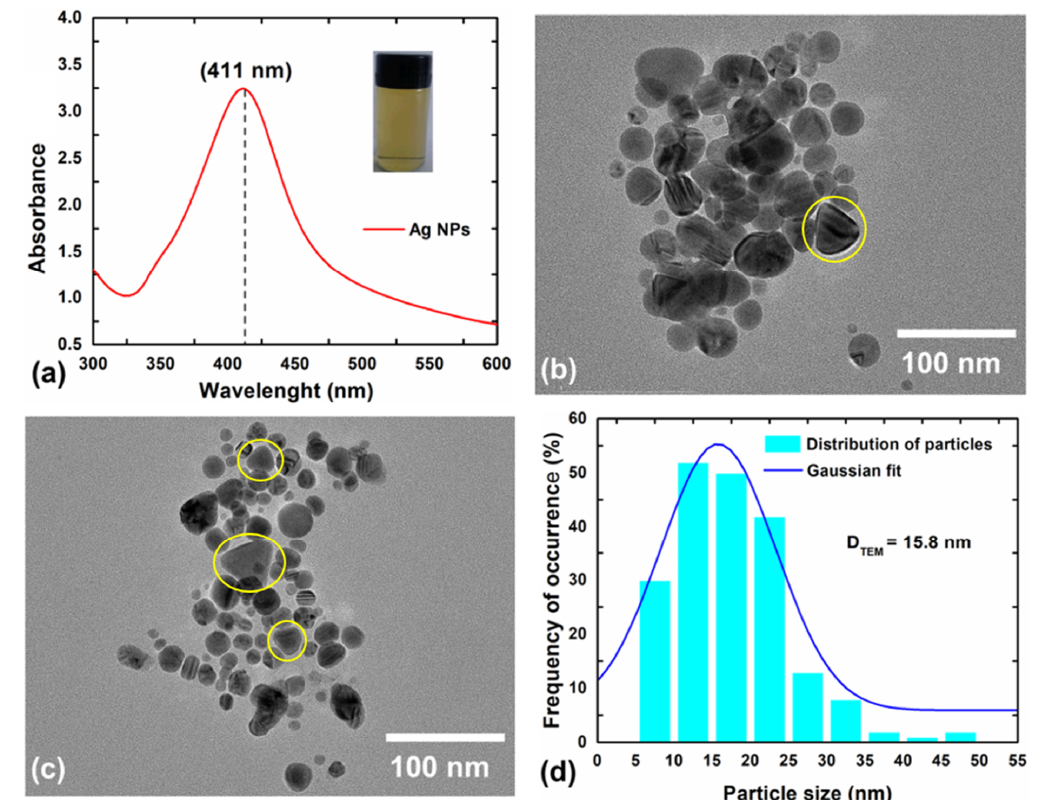
Figure 1. ( a ) UV-vis spectrum, ( b , c ) TEM images, and ( d ) Particle size distribution of AgNPs passivated using citrate in the aqueous medium. The yellow circles highlight the anisotropic prismatic shapes observed for some nanoparticles.